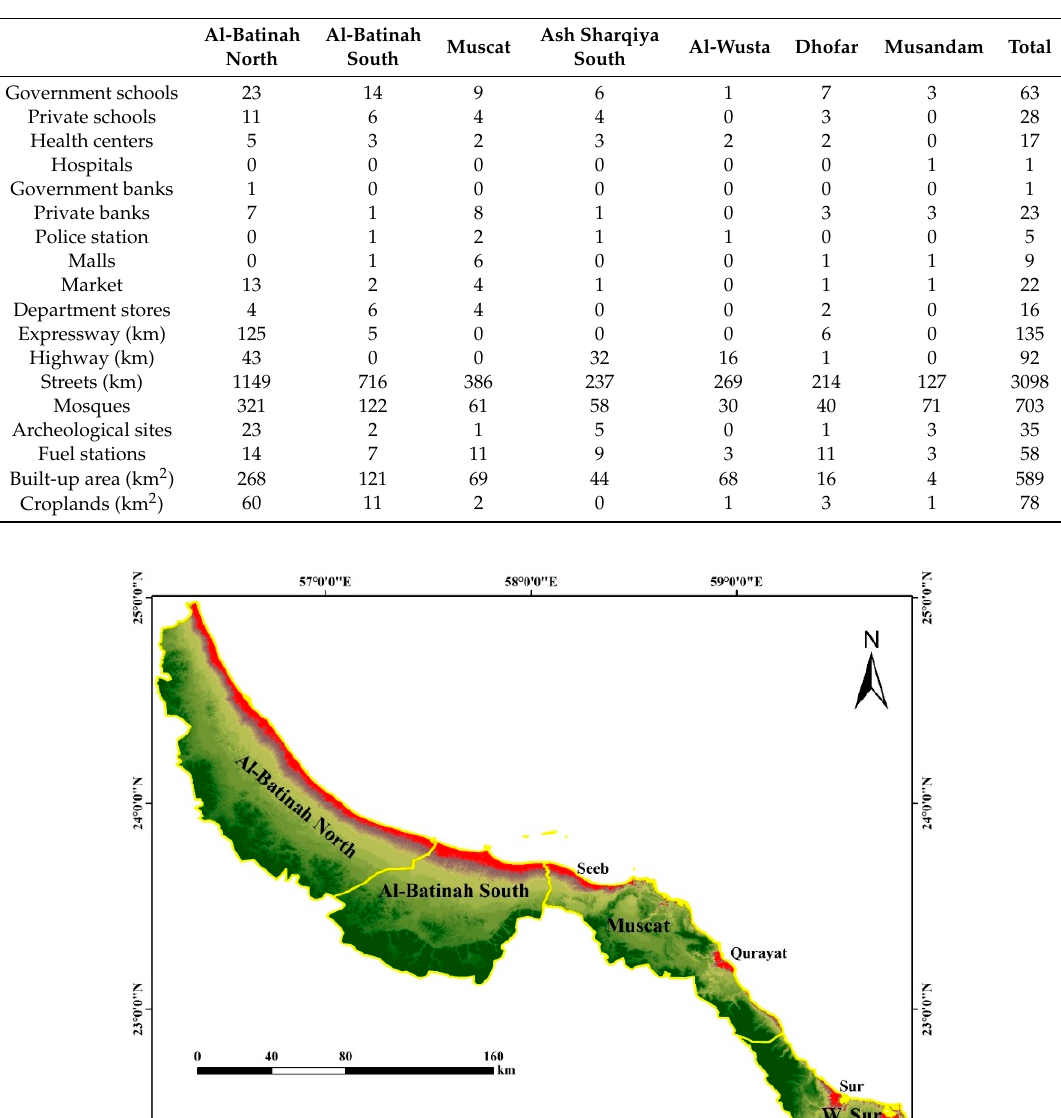
Table 7. The vulnerability matrix of the 10 m tsunami scenario at the governorate level.